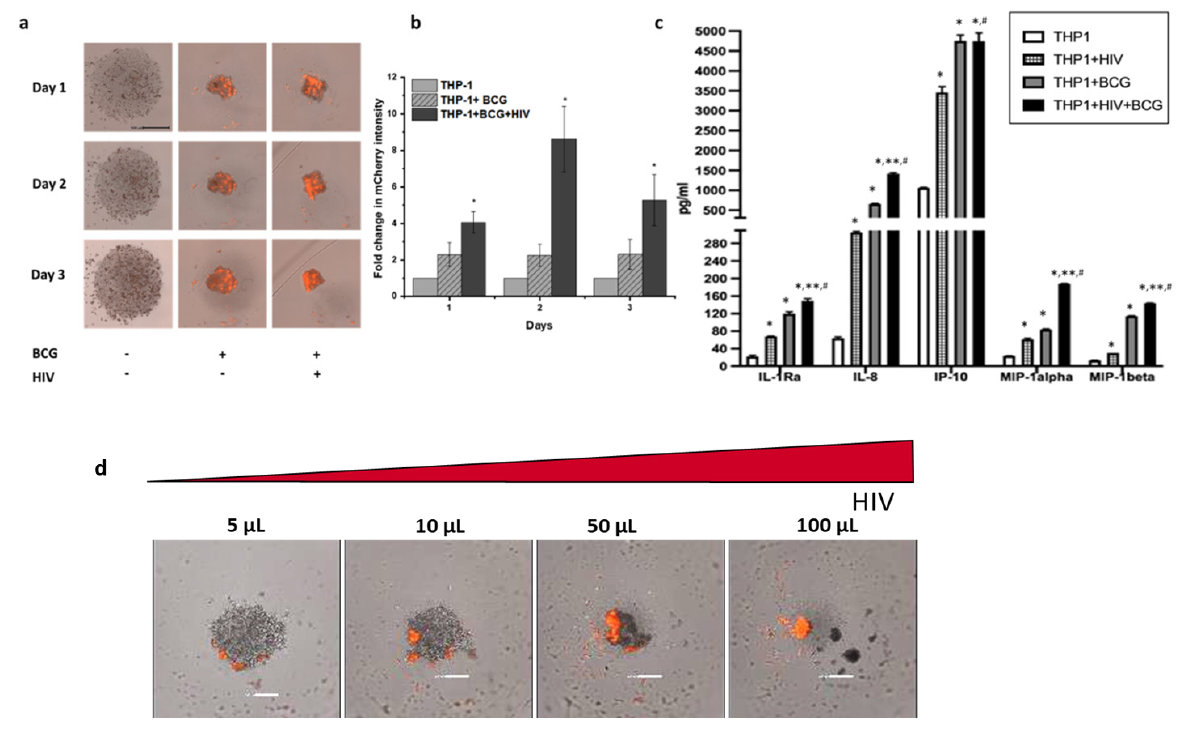
Figure 4: Modeling the interactions in HIV-TB infection and tracking mycobacteria using Image cytometry. a) Images of THP-1 spheroids generated by infecting 10,000 THP1 with BCG mCherry and HIV tracked over a period of 3 days. Data organized into 3 panels. Left to the right represents no infection control, BCG single infection group and HIV and BCG dual infection. Top to bottom represents increasing time in culture (N=3). (b) BCG mCherry proliferation by quantification of intensity over time. One-way Anova was used to determine statistical significance between BCG infected granulomas with and without HIV infection. * represents statistical significance, p<0.05, (n=3) when compared to the THP-1 with BCG group. (c). Cytokine and chemokine levels in untreated vs. BCG and HIV-treated THP-1 spheroids assessed by multiplex cytokine analysis (n=2). Paired two-tail T-test was used to determine significance between the sample groups. * denotes statistical significance when compared to THP-1 control group with no infection at p<0.05. **, # represents the statistical significance of HIV-TB co-infection group when compared to BCG and HIV single infection respectively at p<0.05. (d) Images of THP-1 cell (Bright field) co-infected with BCG mCherry (Red) and HIV pseudotyped